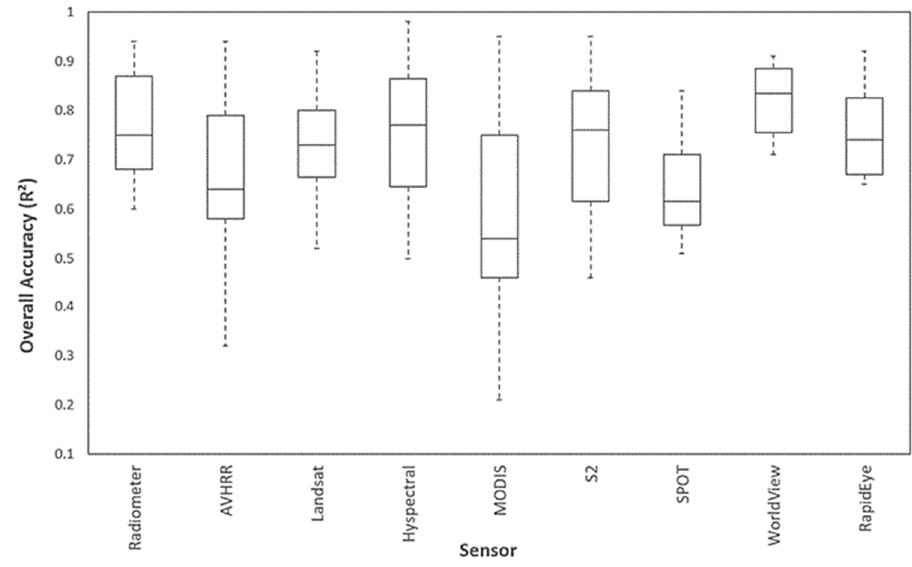
Figure 8. Overall accuracies of the various sensors used in monitoring grassland vegetation a tt rib-